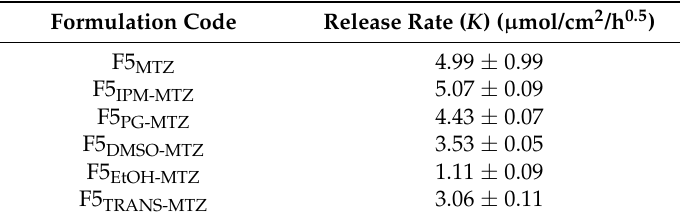
Table 2. Release rates of Pal-GH gel formulations.